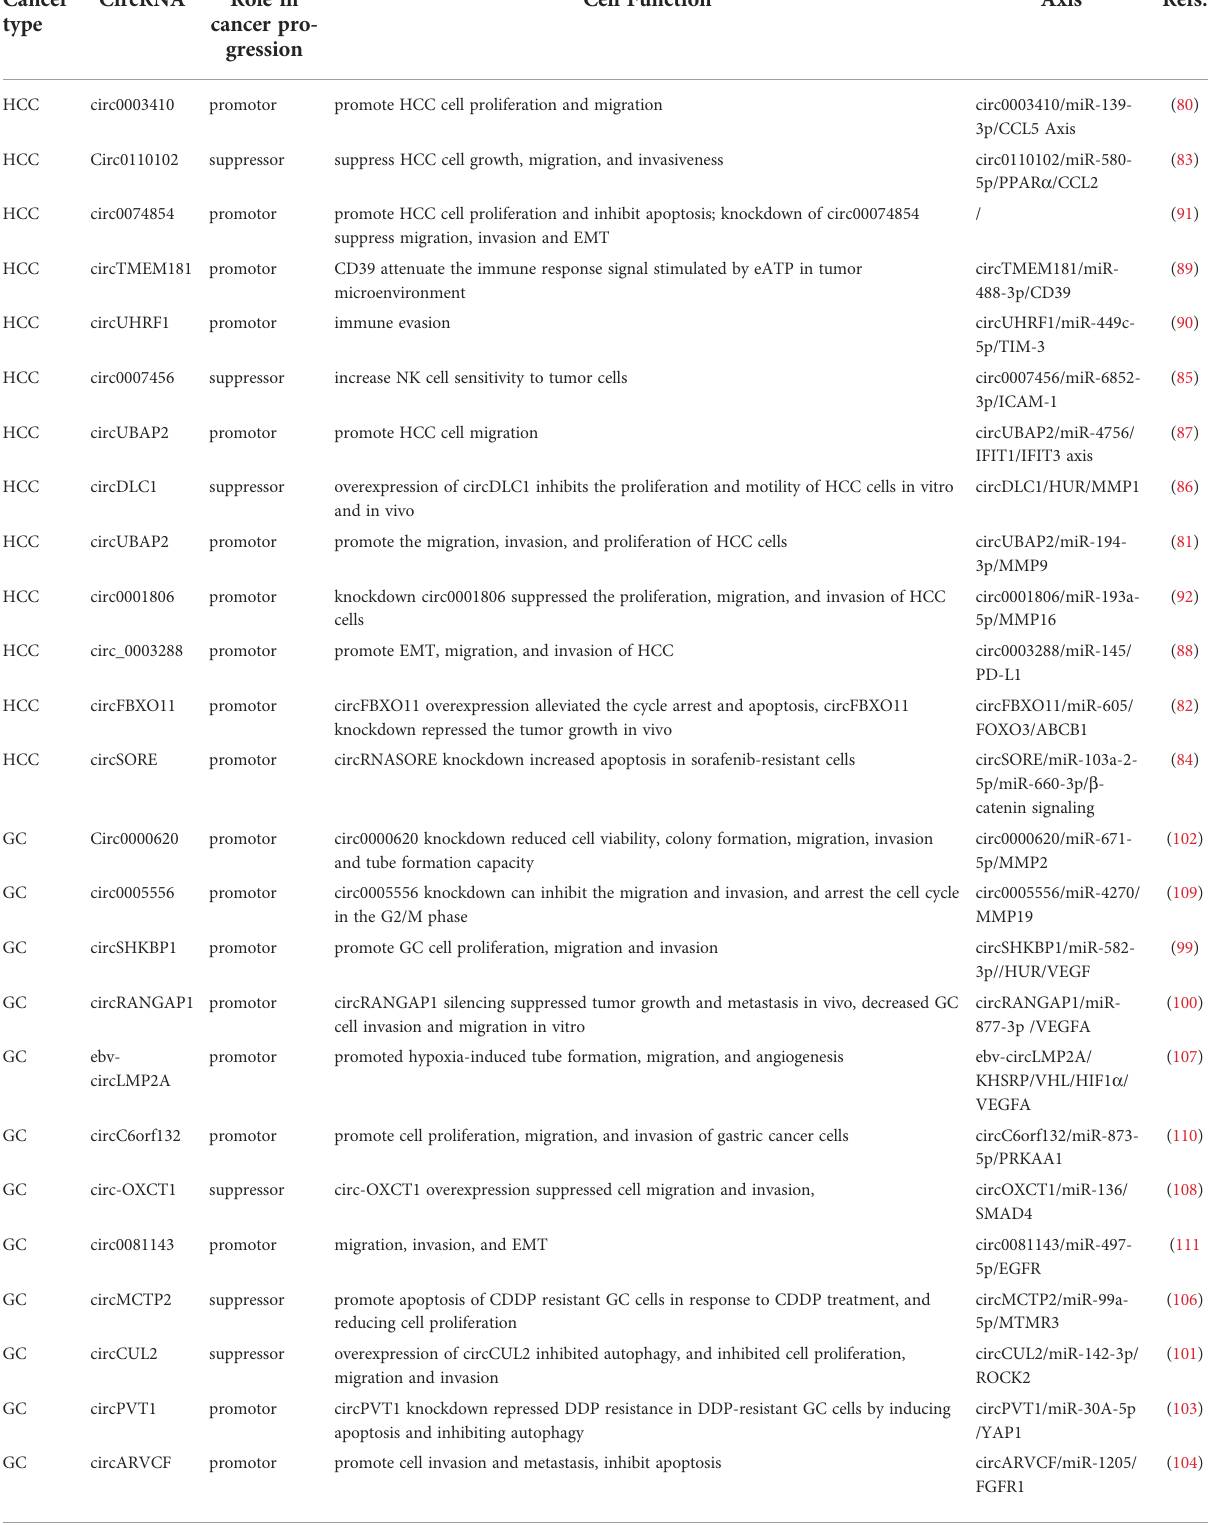
TABLE 1 Cytological function and molecular axis of circRNA in various digestive system tumors. Cancer